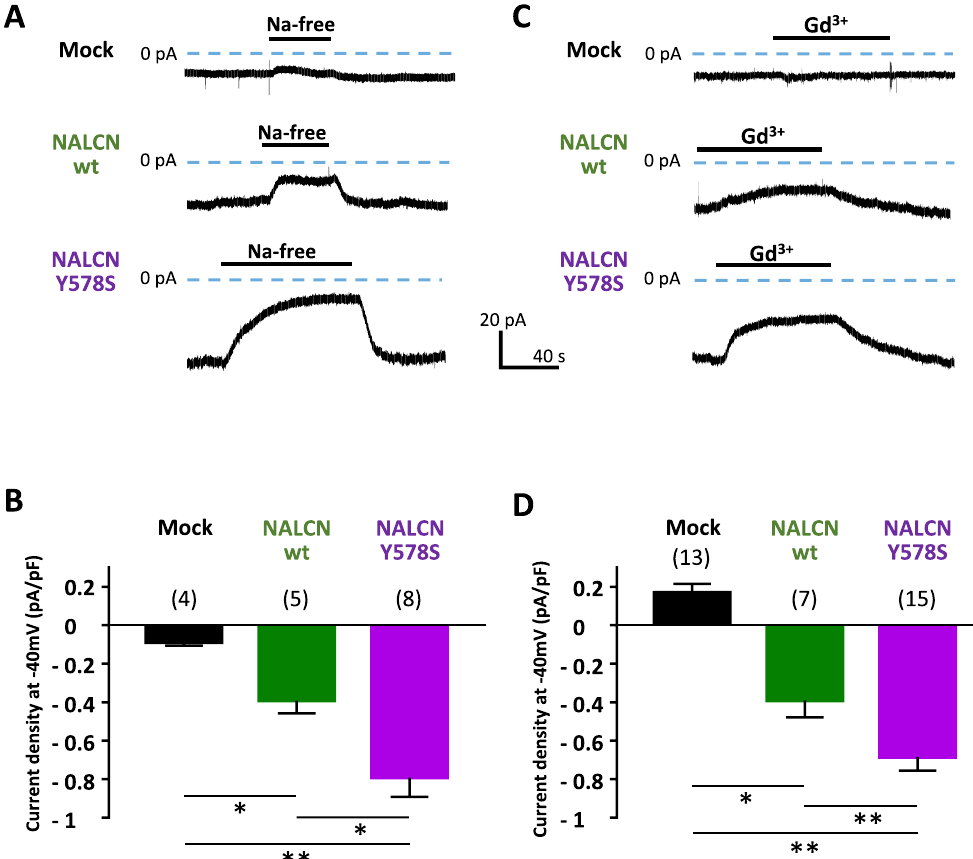
Figure 2. Transient expression of the wild-type (wt) NALCN and its CLIFAHDD variant Y578S together with NLF1 in differentiated NG108-15 cells results in the expression of a NMDG- and Gd 3 + -sensitive background Na + current. ( A ) Representative traces obtained on cells held at − 40 mV (HP) during application/wash of an extracellular Na + -free solution (replaced with NMDG) for a mock (NLF1)-transfected cell (top), a NALCN/ NLF1 (wt)-transfected cell (middle), a NALCN CLIFAHDD mutant (Y578S)/NLF1-transfected cell (bottom). ( B ) Density of the external Na + -dependent background current (Na + -free) for mock-transfected cells ( − 0.088 ± 0.03 pA/pF, n = 4); NALCN: − 0.391 ± 0.14 pA/pF, n = 5; NALCN-Y578S: − 0.79 ± 0.32 pA/pF, n = 8). ( C ) Representative traces obtained on cells held at − 40 mV during application/wash of Gd 3 + (10 µ M) for a mock-transfected cell (top), a NALCN (wt)-transfected cell (middle), a NALCN CLIFAHDD mutant (Y578S)-transfected cell (bottom). ( D ) Average density of the Gd 3 + -sensitive background current for mock- transfected cells (0.168 ± 0.16 pA/pF, n = 13), NALCN (wt)-transfected cells ( − 0,391 ± 0.23 pA/pF, n = 7) and NALCN-Y578S-transfected cells ( − 0.684 ± 0.27 pA/pF, n = 15). Both the Na + -dependent background current and the Gd 3 + -sensitive background current were significantly of higher density for wt NALCN and its pathogenic variant Y758S compared to the control condition (p = 0,03 and 0,004 for the Na + -dependent component and P < 0.0001 and < 0.0001 for the Gd 3 + -sensitive component respectively). In addition, densities of the Na + -dependent background current and the Gd 3 + -sensitive background current were significantly lower for wt NALCN compared to its pathogenic variant Y578S (p = 0.045 and p = 0.029 respectively). p values were calculated with a Mann-Whitney statistical